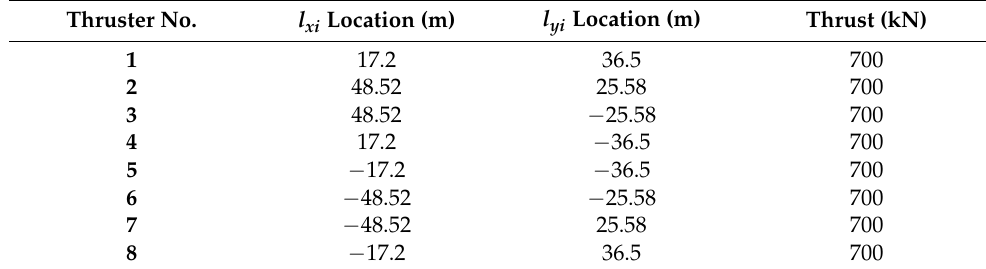
Figure 6. Second-Order wave loads.